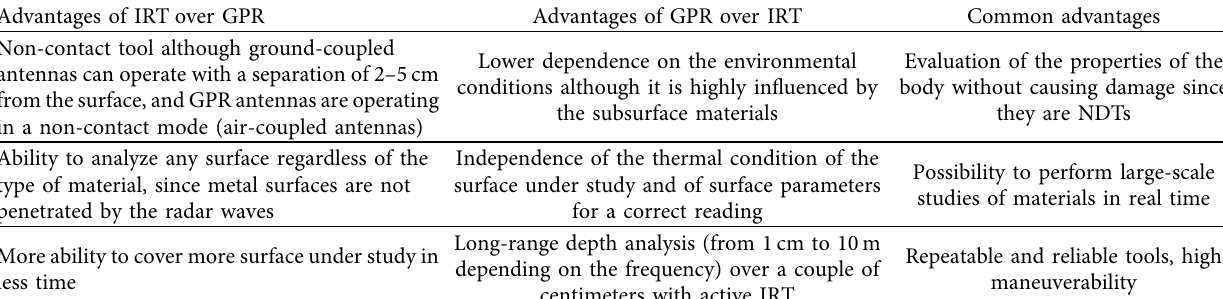
Table 1: Comparison between IRT and GPR techniques. Adapted from